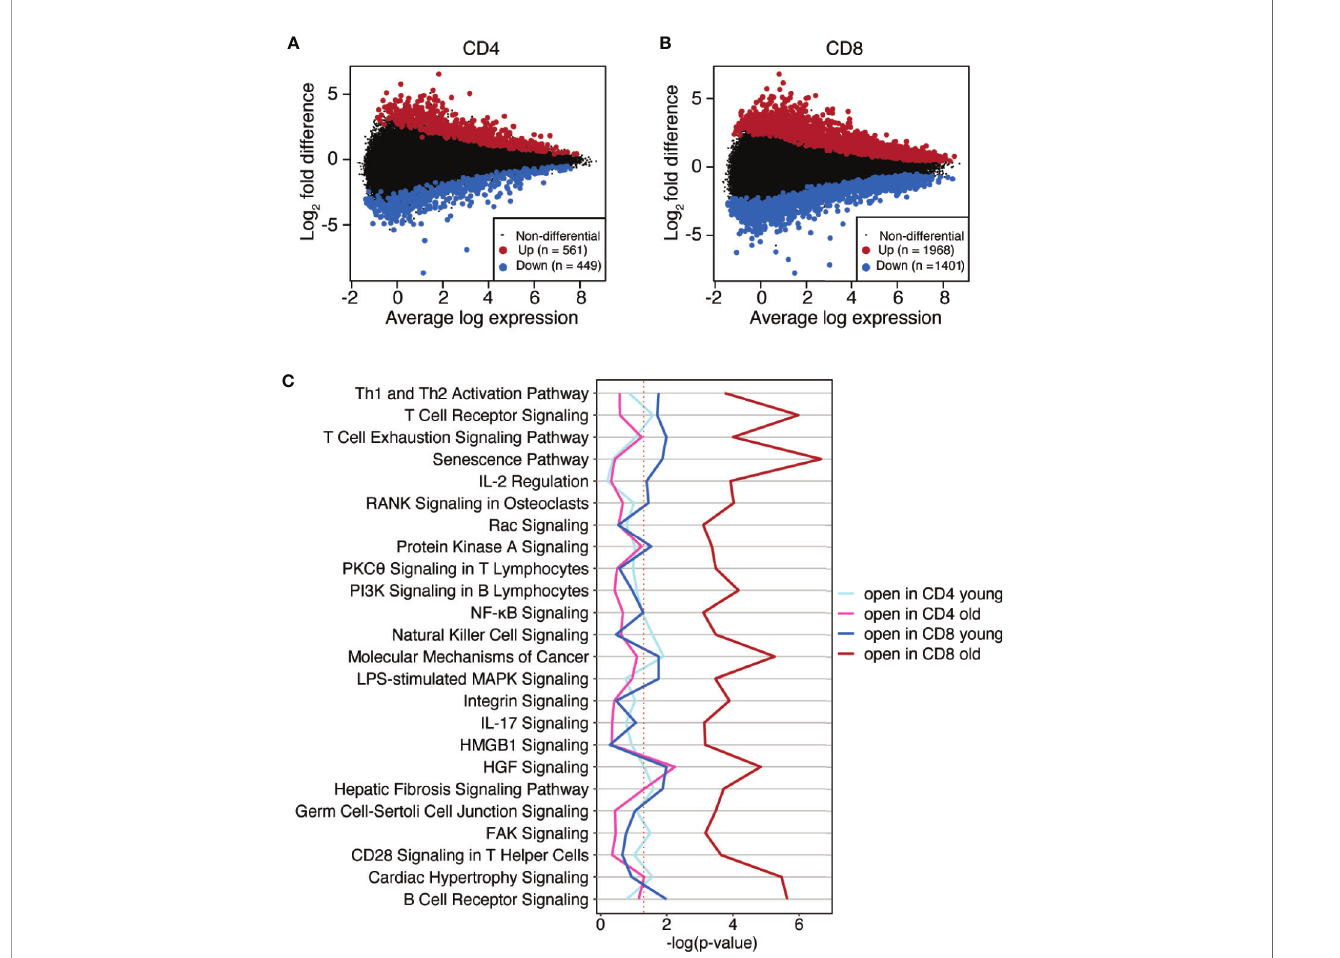
FIGURE 2 | Age-associated differences in chromatin accessibility in CD4 and CD8 T subsets. (A, B) Scatter plots (MA plots) of log2 fold differences between young and old individuals versus the mean of normalized counts. Age-related differences across all differentiation subsets were determined by combining naïve, CM and EM subset-speci fi c differences for CD4 (A) and CD8 T cells (B) . Colored dots [more accessible in old (red) or young (blue)] indicate differentially accessible sites with Benjamini-Hochberg adjusted p-values of <0.05. (C) Age-associated, differentially accessible sites were assigned to genes by GREAT. Gene lists were used to identify most enriched canonical pathways by Ingenuity Pathway Analysis. X-axis shows the adjusted p-value, red dash line indicates adjusted p-value of